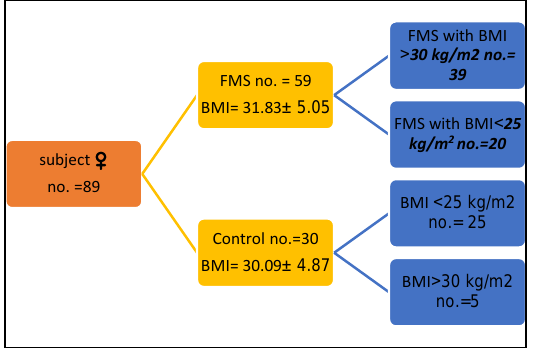
Figure2.Demographic distribution of (FMS and control) women according to BMI in this study.